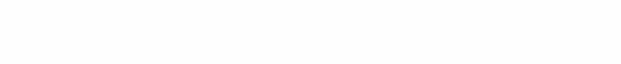
FIGURE 1 Lumped mass structural model.